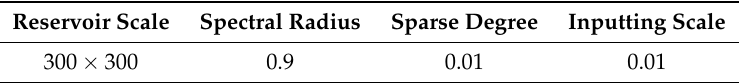
Table 2. Parameter Settings of the Dynamic Reservoir of ESN.